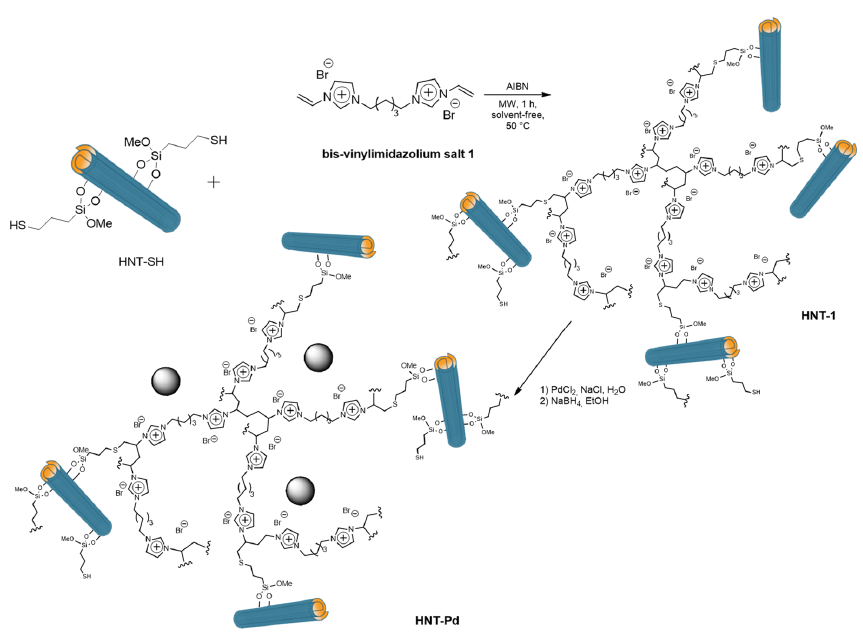
Figure 14. Schematic representation of the synthesis of HNTs-Pd catalyst.